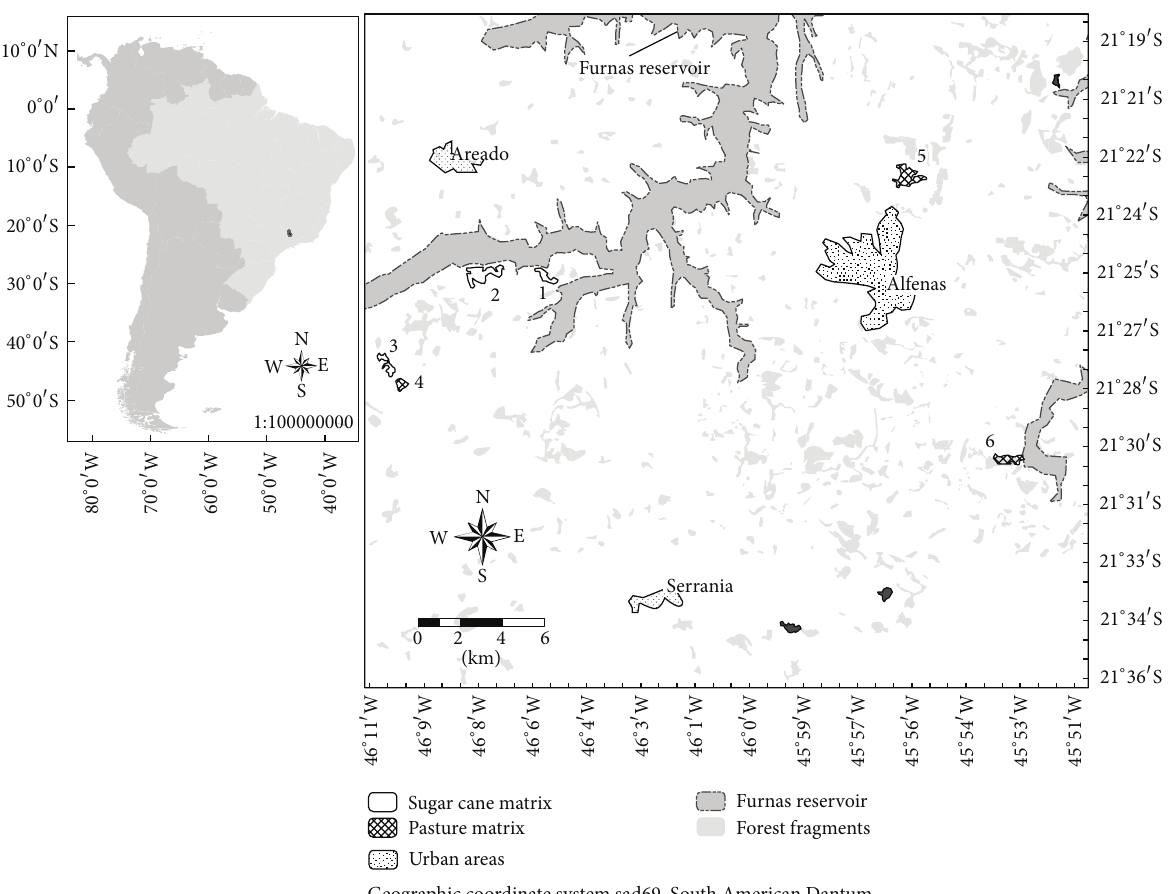
Figure 1: Study area location in the surroundings of the cities of urban areas, in the state of Minas Gerais, Brazil, and the six forest fragments sampled.